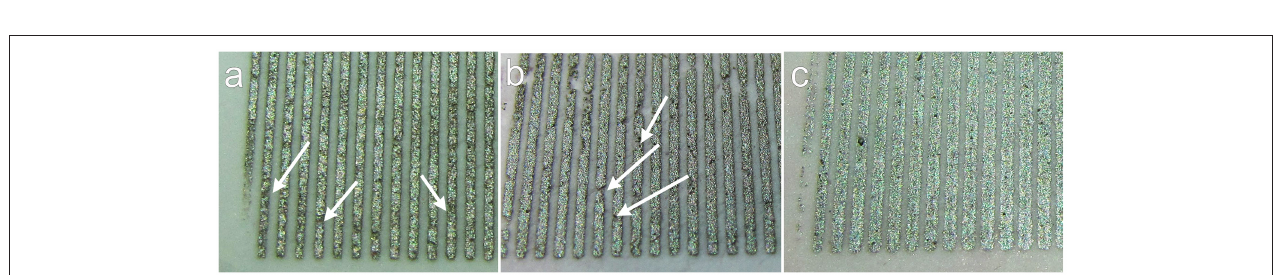
FIGURE 3 | Surface profiles and roughness values for different samples. Zero height is set as the lowest point for each sample. (A) Uncoated sample with the highest roughness. (B) Sample with LMO-coating with lower roughness. (C) CNF coated sample with the smoothest surface of HGMS composites. (D) Surface roughness measured for the HGMS composite samples, printing paper, sintered ceramic substrate, and PET sheet.